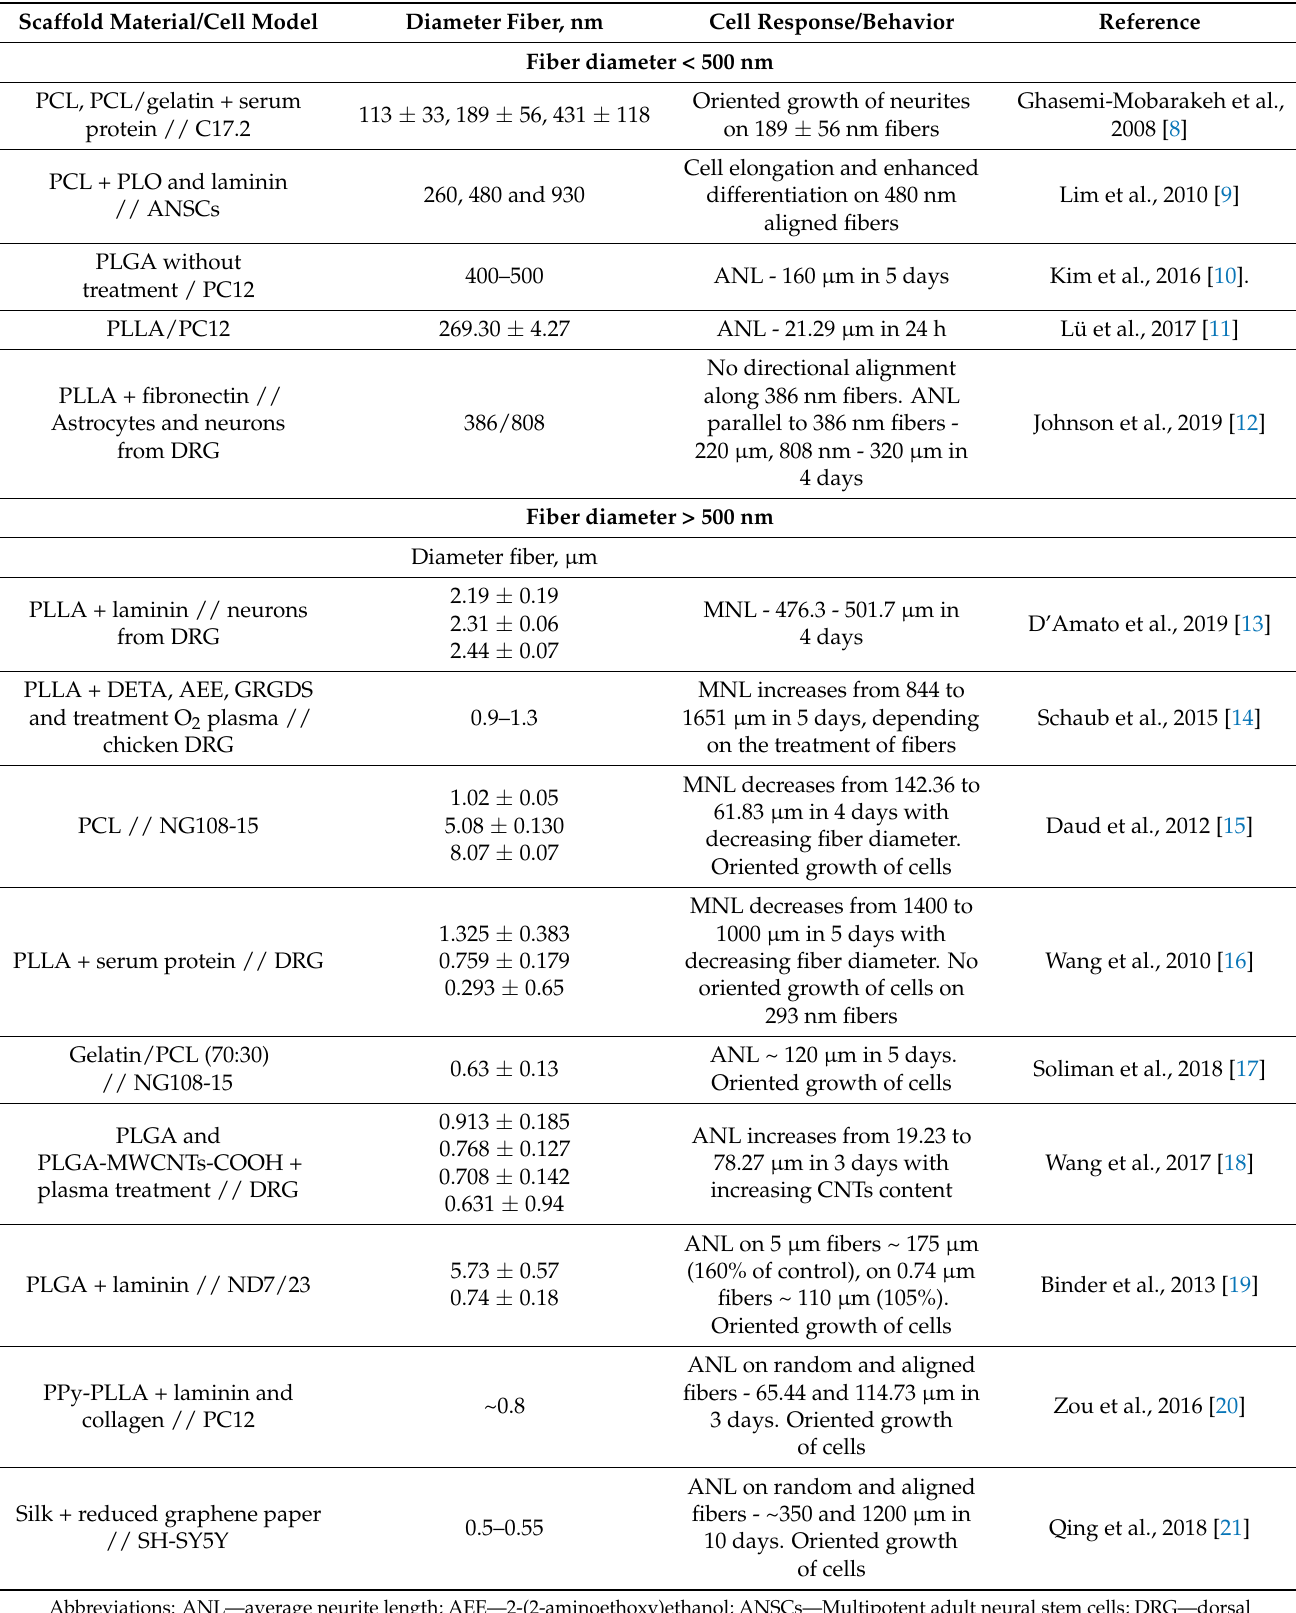
Table 1. Summary of the nanofiber size effects on neuron